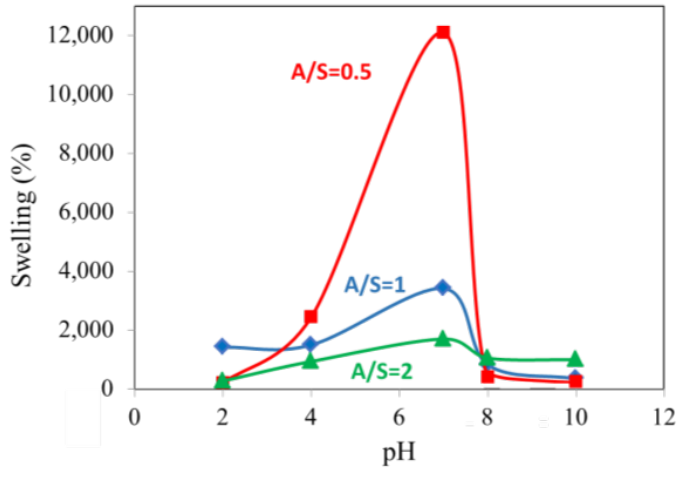
Figure 5. pH-responsive behavior of HPMC-g-poly(AM-co-SPA) hydrogels.